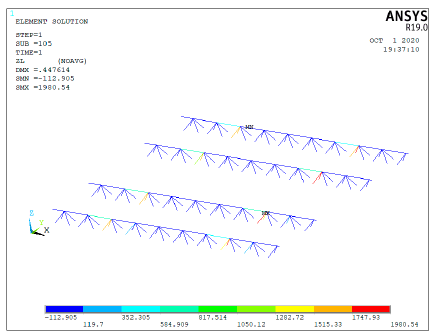
Figure 36. Stress cloud diagram of truss rib under ultimate load.